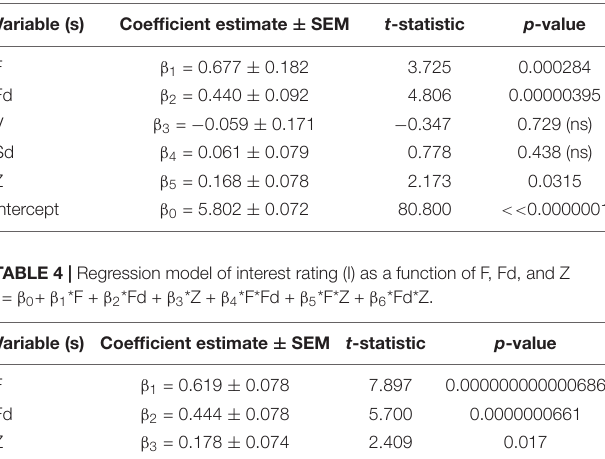
TABLE 3 | Regression model of interest rating (I) as a function of eye tracking predictor variables and Z I = β 0 + β 1 *F + β 2 *Fd + β 3 *V + β 4 *Sd + β 5 *Z.